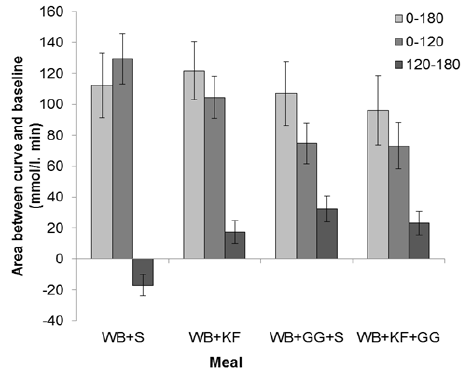
Figure 5. Distribution of incremental areas under the blood glucose response curve in the meals consumed: Wheat bix+sugars (WB+S), WB+kiwifruit (WB+KF), WB+guar gum+sugars (WB+GG+S), and WB+KF+GG. (Means ± sem). LSDs: 0–180 min, 38.9 ( p = 0.61); 0–120 min, 28.0 ( p < 0.001); 120–180 min, 16.0 ( p < 0.001).